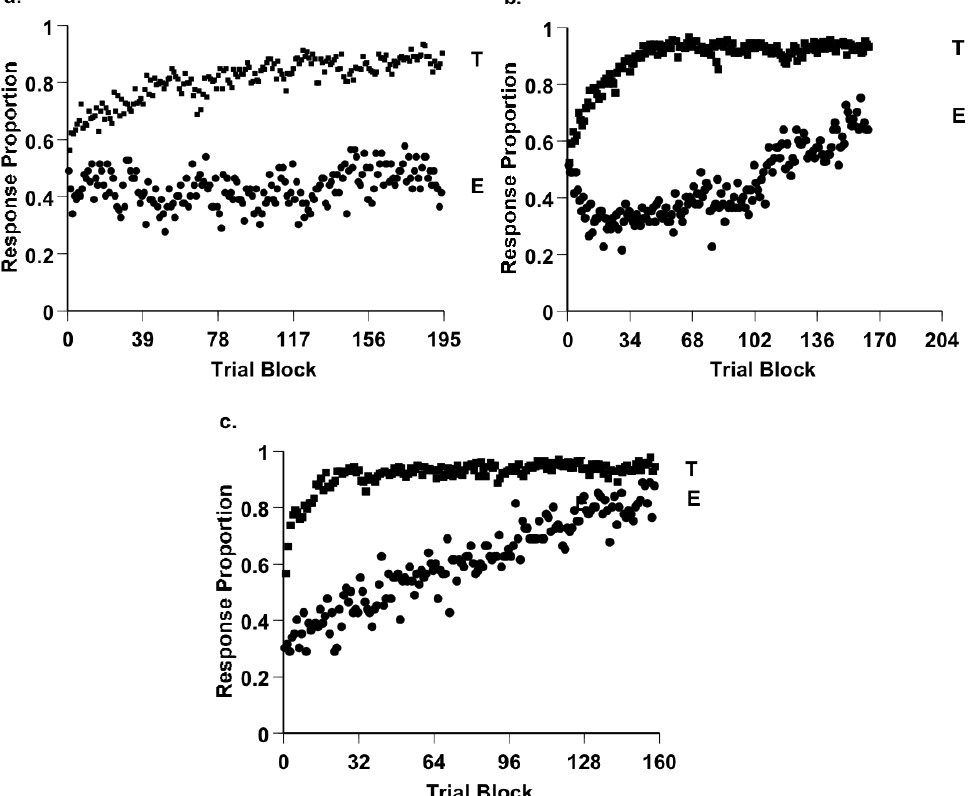
Figure 5. (a–c) The performance of monkeys Hank, Lou, and Murph by 64-trial blocks in the category task of Smith et al. [40]. Curves T and E, respectively, show the proportion of correct responses made to the six typical and two exception items in each category. From [40]. Copyright 2010 by the American Psychological Association. Reprinted with permission.